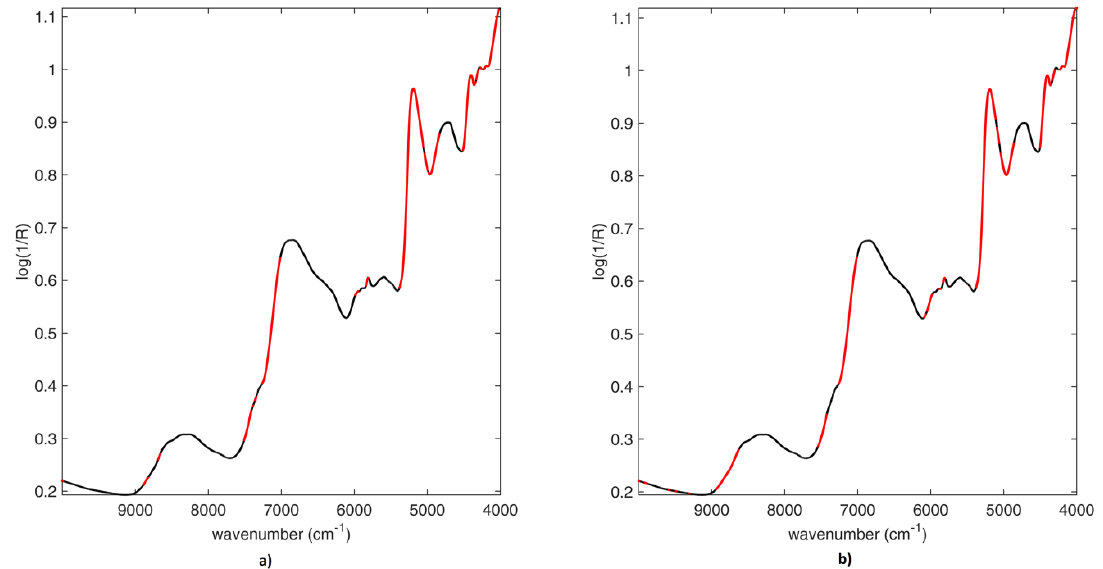
Figure A2. VIP Analysis: Mean spectrum (black line). Variables presenting a VIP index > 1 are highlighted in red. ( a ) Variables selected on the spectra collected on the nutshells. ( b ) Variables selected on the spectra collected on the kernels.